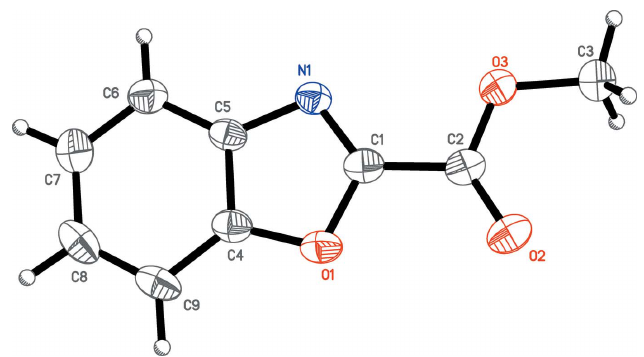
Figure 1 The molecular structure of the title compound with the atom numbering. The displacement ellipsoids are drawn at the 50% probability level.